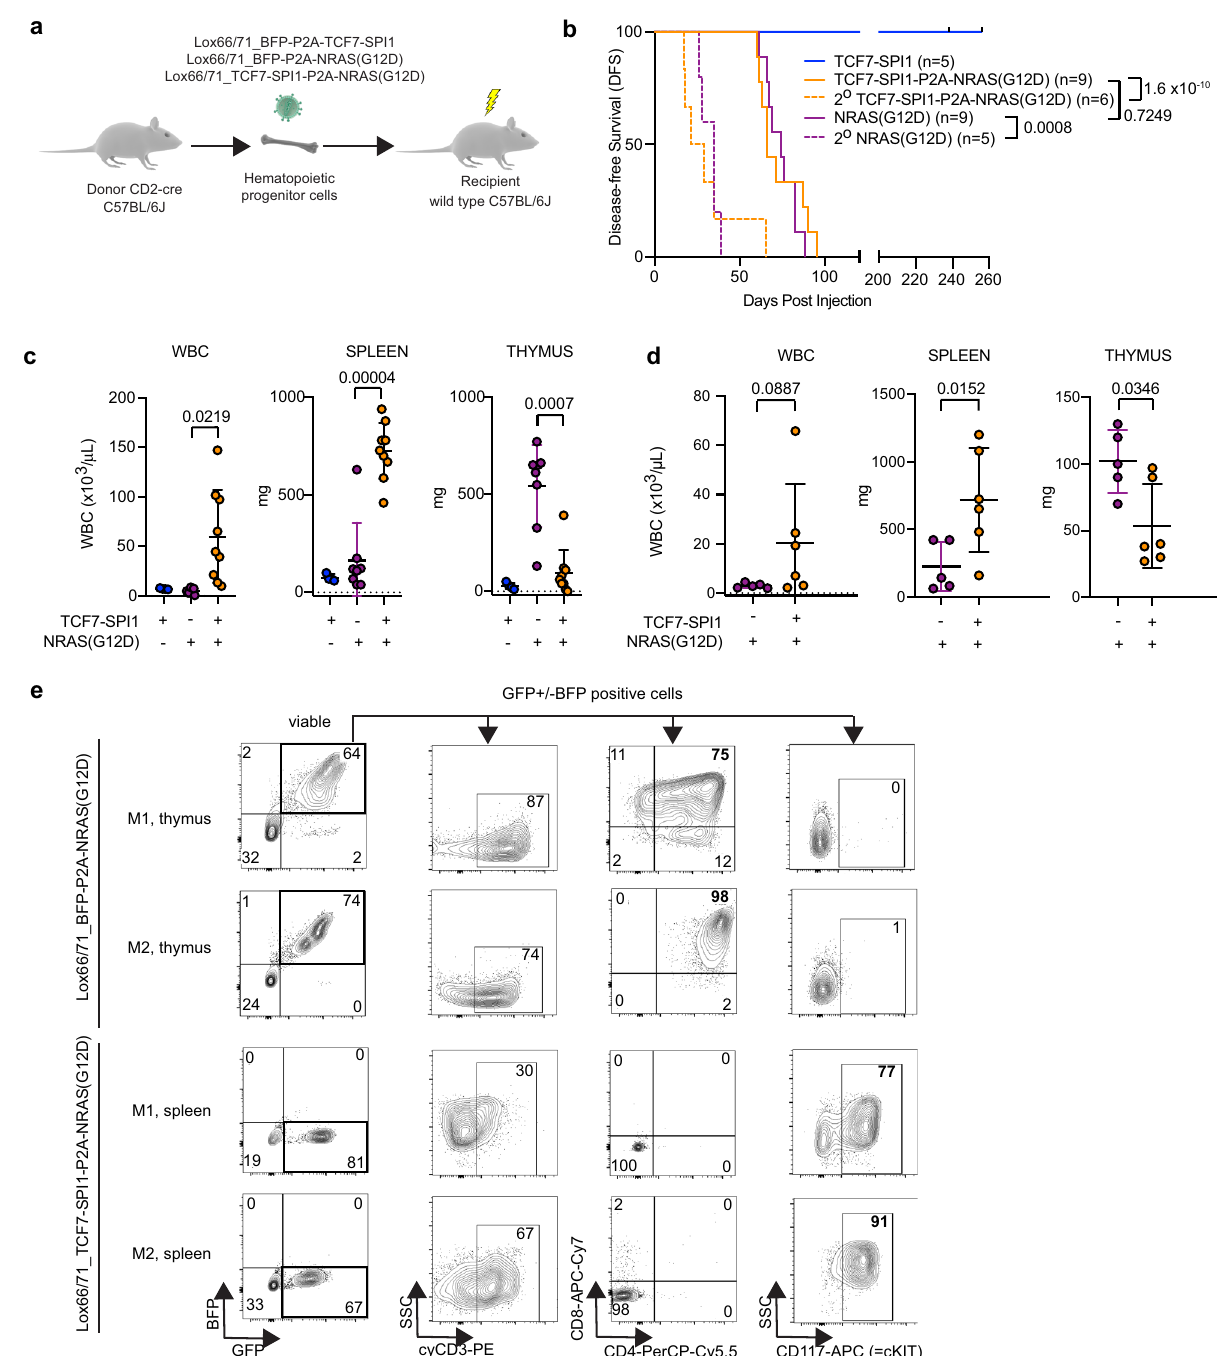
Fig. 4 Conditional co-expression of TCF7-SPI1 fusion and NRAS(G12D) within developing T cells cooperate to generate an immature T-cell acute lymphoblastic leukemia. a Schematic representation of the conditional bone marrow transplant (BMT) model. b Survival curve showing the disease-free survival with no signi fi cant difference in disease latency between NRAS only and TCF7-SPI1-P2A-NRAS ( p = 0.7429). Secondary transplantations (dashed lines) have signi fi cantly shorter disease latencies ( p = 0.0008 for NRAS only; p = <0.0001 for TCF7-SPI1-P2A-NRAS). Log-rank (Mantel – Cox) test. c White blood cell (WBC), spleen weight and thymus weight at end stage for the primary BMT. n = 4 biologically independent animals for TCF7-SPI1, 8 for NRAS only (for the WBC graph n = 9) and n = 9 biologically independent animals for TCF7-SPI1 + NRAS in the three graphs. d Equivalent WBC, spleen, and thymus data for secondary transplantation. c , d Each point represents a different mouse, n = 5 biologically independent animals for NRAS only and 6 for TCF7-SPI1 + NRAS; the mean is shown with standard deviation. P values are indicated and were calculated by a one-way ANOVA with post hoc Dunnett T3 multiple comparisons test for ( c ) and a two-tailed Mann – Whitney test for ( d ). e Immunophenotyping of two different mice from ( b ) for each condition with spleen or thymus cells. Flow cytometry for cyCD3, CD4, CD8, CD117 are shown after gating on the viable and GFP + cells. Distinguishing markers between the two conditions and their respective percentages are highlighted in